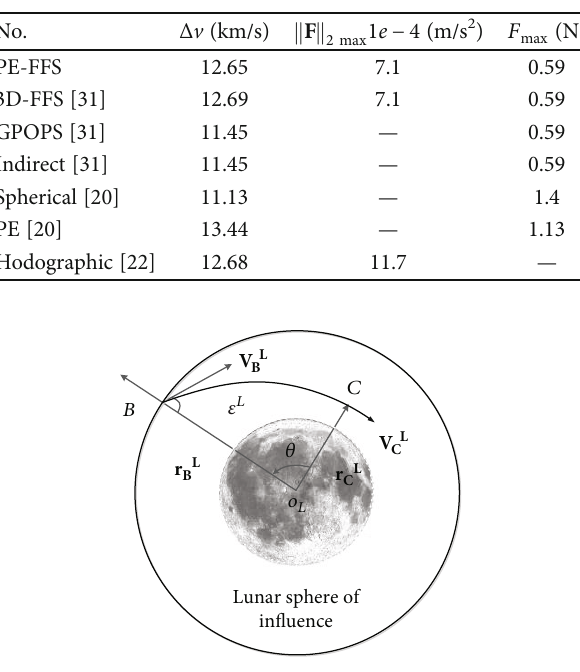
Figure 10: Launch window analysis of the comet Tempel-1 rendezvous mission. Table 7: Comparison of the comet Tempel-1 rendezvous trajectory results by di ff erent methods.